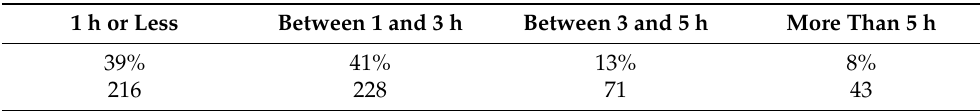
Table 6. Respondents’ online usage time